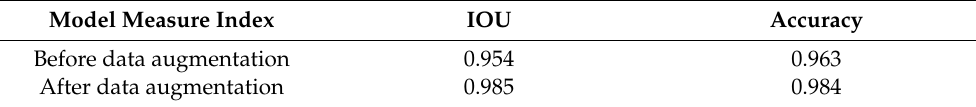
Table 2. Model indicators before and after data augmentation.